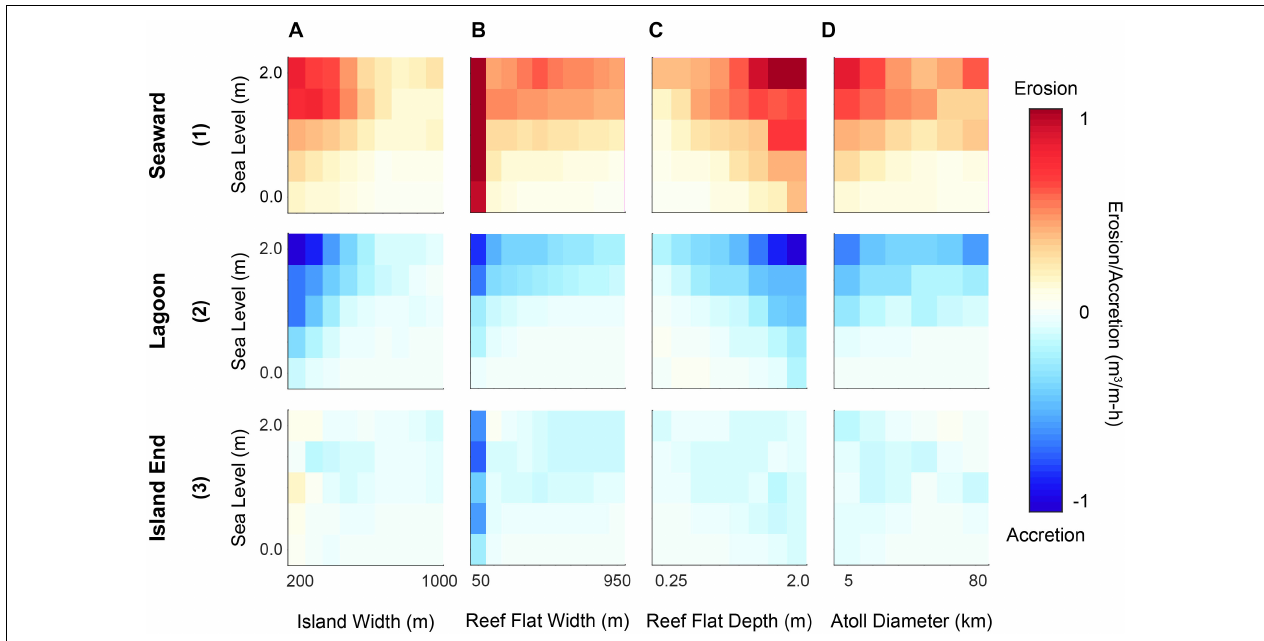
FIGURE 2 | Relative changes in shoreline erosion/accretion magnitudes with morphological parameter (x-axes) and SLR (y-axes) for the windward island. Rows describe (1) seaward, (2) lagoon, and (3) island end shorelines; columns denote morphological parameters (A) island width, (B) reef flat width, (C) reef flat depth, and (D) atoll diameter. Red indicates net erosion and blue net accretion, with increasing color intensity indicating greater magnitude. The color ramp is linear, but absolute magnitudes are unlisted to address only relative changes.